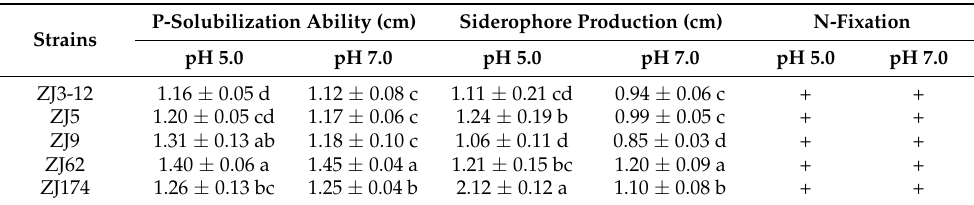
Table 1. The ability of the five selected bacterial strains in P-solubilization, siderophores production and N-fixation.